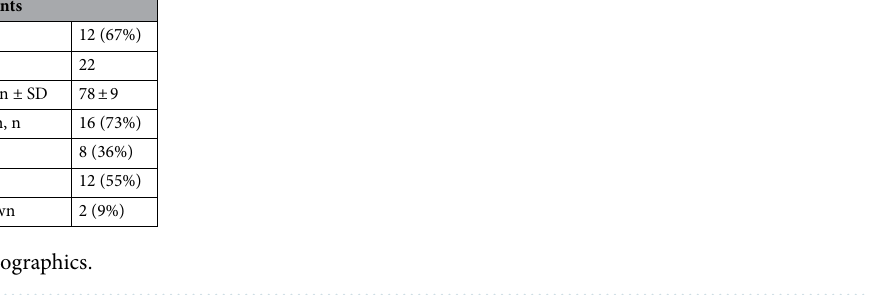
Manual measurements vs calculated measurements. The manually measured orientation param- eters were normally or lognormally distributed, implying ICC could be used in further analysis 20 . CI F , SI F and